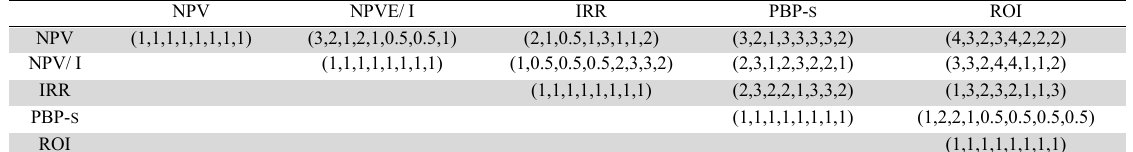
Comparison of different financial criteria